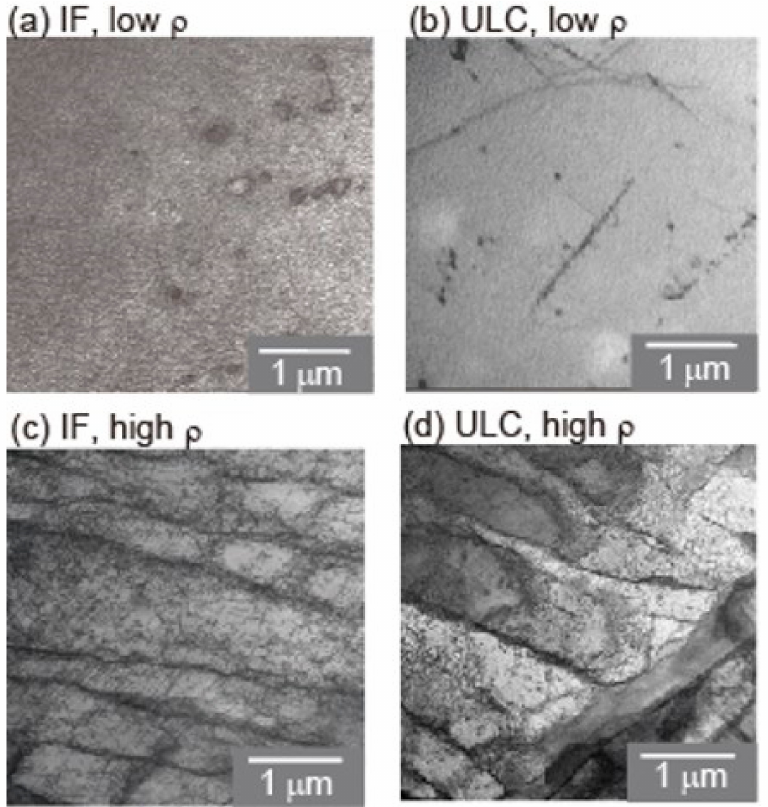
Figure 9. STEM micrographs for interstitial free (IF) steels with different dislocation densities